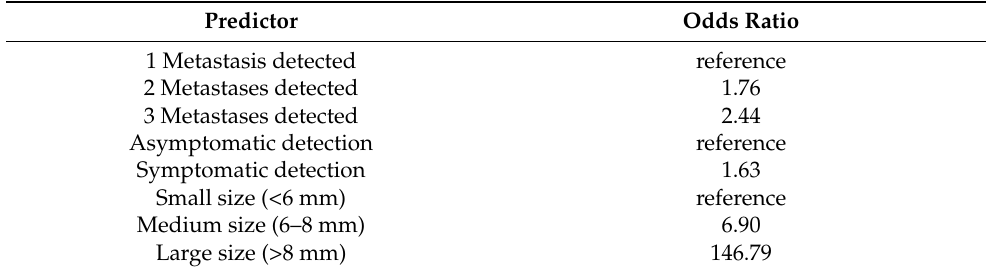
Table 3. Odds Ratios predicted by the logistic regression model.